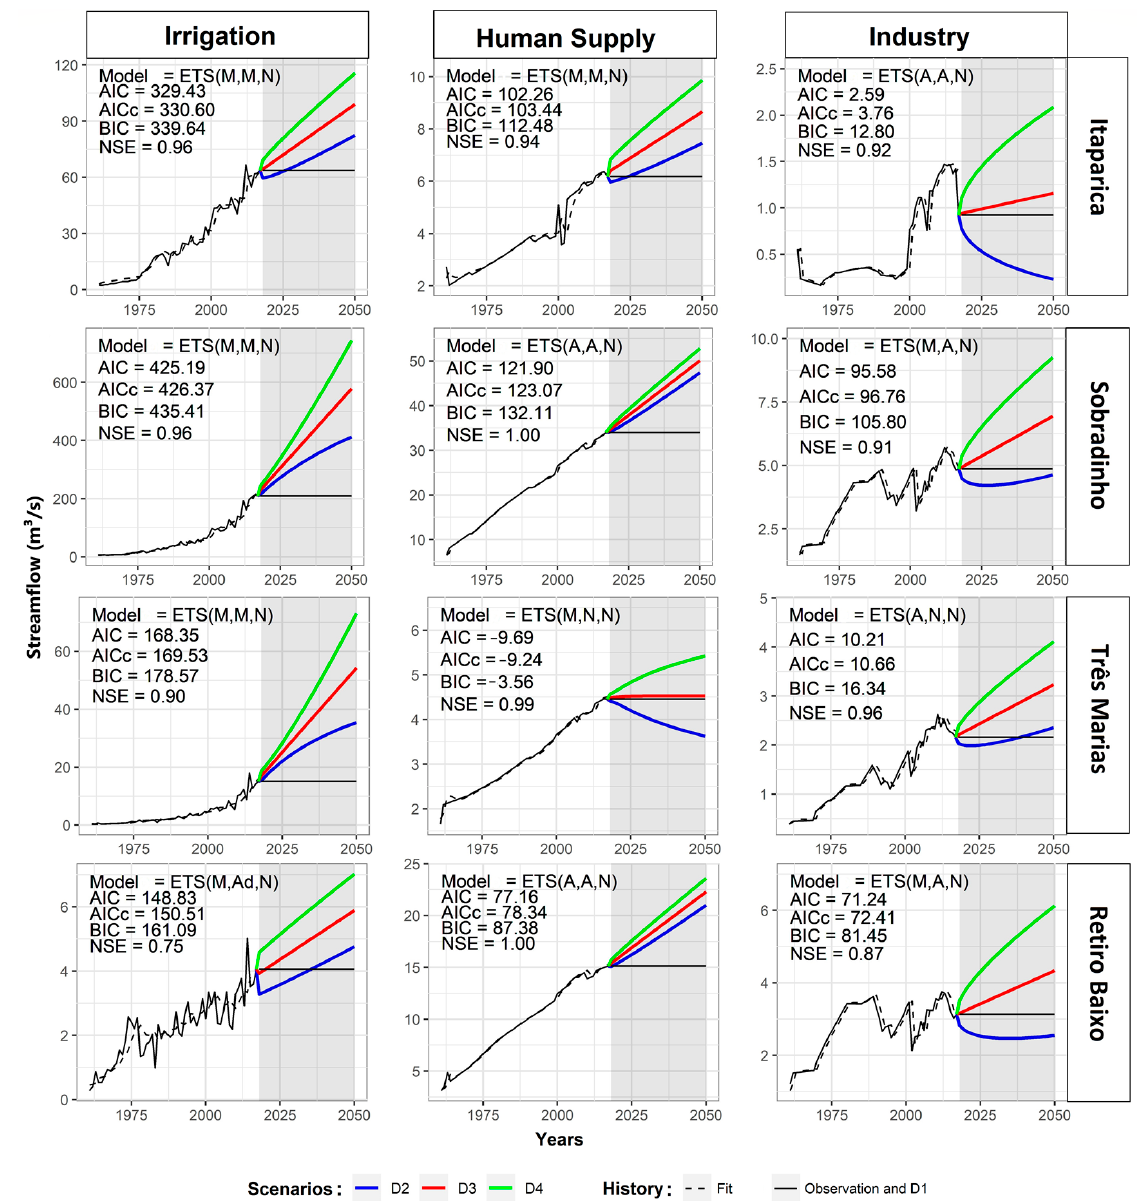
Figure 8. Historical consumptive demands and future scenarios (D1, D2, D3 and D4).